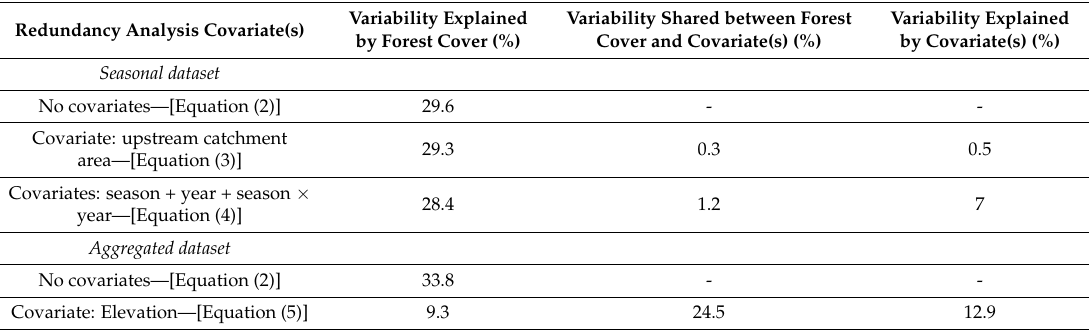
Table 2. Redundancy analysis results for seasonal dataset (October–March and April–September) and aggregated dataset (median value over the study period): variability (%) explained by forest cover, by covariates and shared effects.